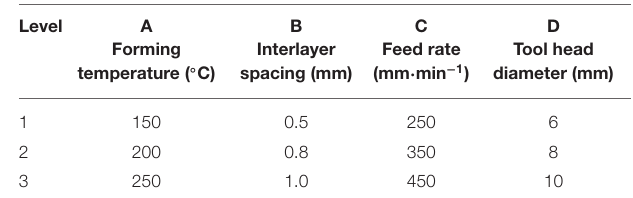
Equation (2): TABLE 2 | Test factors and